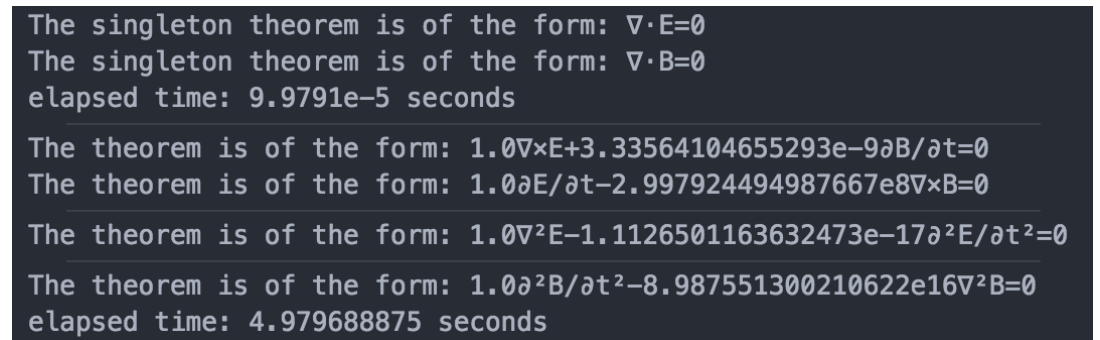
Figure 3. Screenshot of TheoSea ’s output showing the Maxwell Equations and the wave equations of light including the speed of light c ≈ 2.99 × 10 8 .